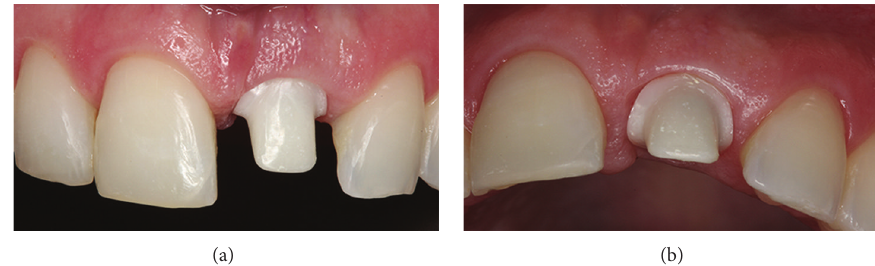
Figure 11: Buccal and occlusal views, showing the custom abutment in zirconia with a CAD/CAM system.